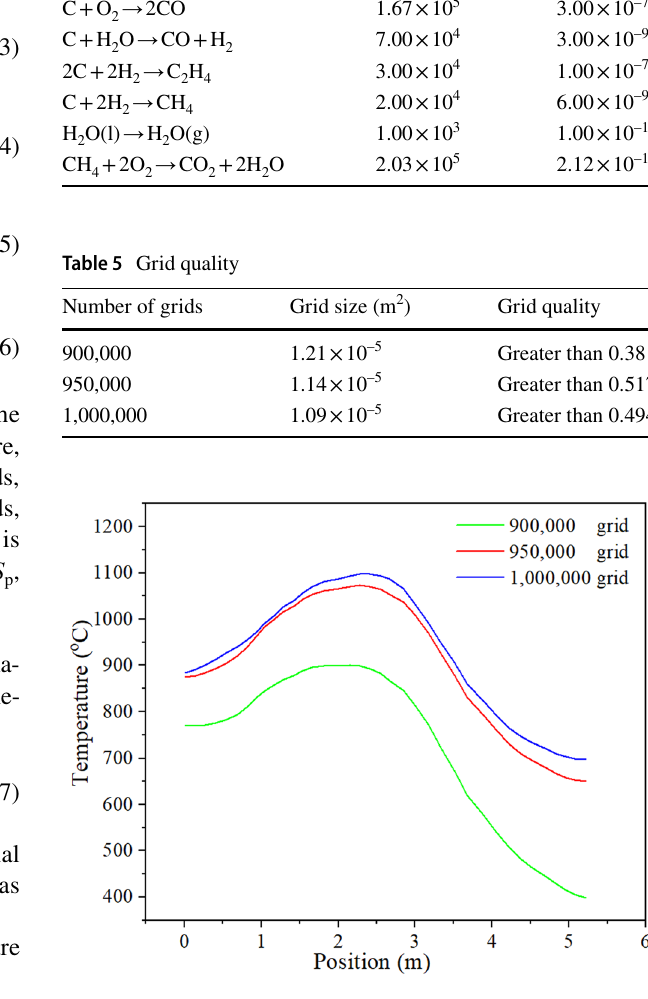
Fig. 4 Results of the grid independence test for the temperature